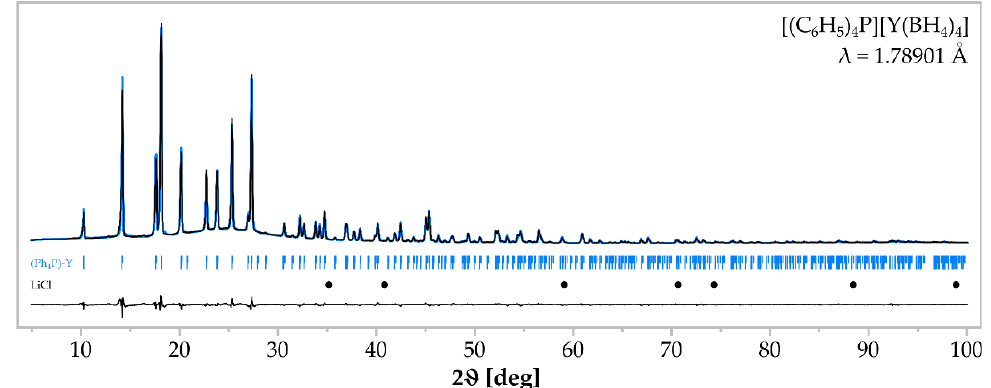
Figure 4. Rietveld analysis of the product sample 2 comprising [Ph 4 P][Y(BH 4 ) 4 ]. The black profile represents experimental data; blue line — calculated profile. Positions of Bragg reflections for [Ph 4 P][Y(BH 4 ) 4 ] (blue marks) and LiCl (black dots, not refined) are shown below. A difference curve (between the experimental and calculated profiles) is plotted at the bottom. Table 2. Comparison of unit cell parameters for [Ph 4 P][Y(BH 4 ) 4 ] and isostructural compounds. Parameter